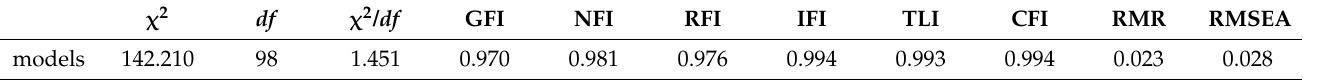
Figure 1. Confirmatory factor analysis of sense of workplace involution. Table 3. Fit indices for the confirmatory factor analysis of the